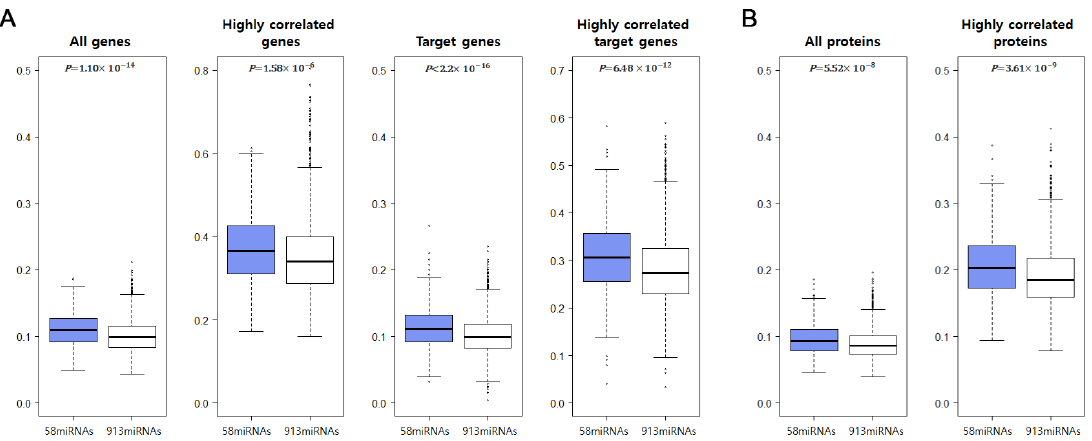
Figure 7. Boxplots showing the relationship between CC-SCNA-miRNAs and mRNA/protein expression. The mean absolute PCCs of CC-SCNA-miRNAs and genes were compared to the mean absolute PCCs obtained for the correlation between the other 913 miRNAs and gene expression. ( A ) Expression of all mRNAs, top 1% genes, target genes of miRNAs, top 5% target genes of miRNAs, and ( B ) all protein expression levels and top 20% proteins were